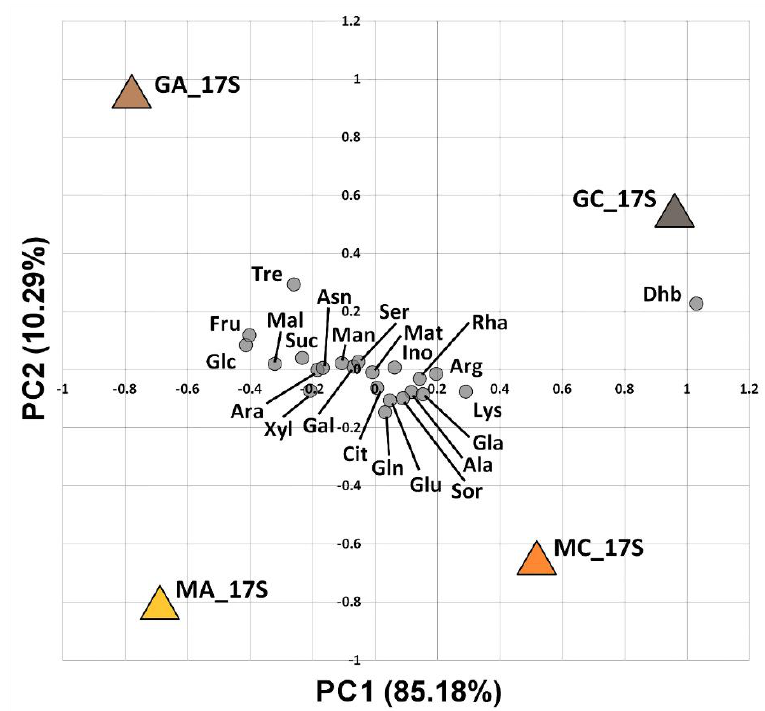
Figure 2. The PCA biplot of the maize monoculture and grassland samples as objects and organic carbon sources as variables based on the MicroResp ™ data. (For substrate abbreviations see Figure 1; for sample designations see Table 1.)